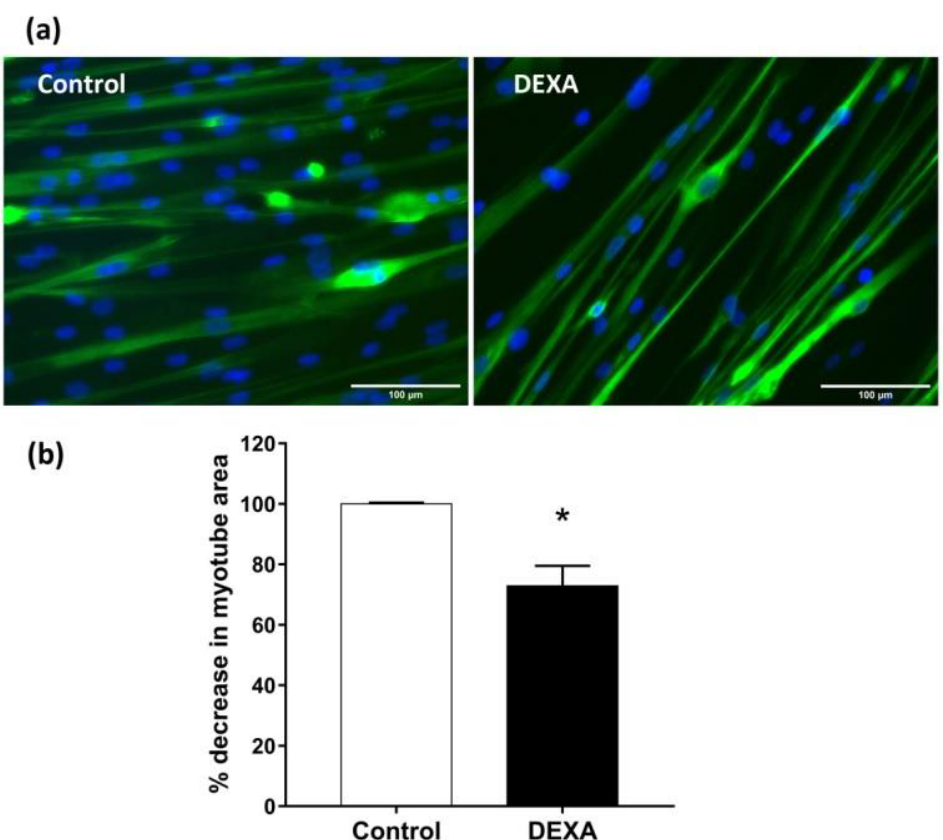
Figure 5. Induction of atrophy in HSMM myotubes. ( a ) Differentiated myotubes were treated with 50 µM of DEXA for 48 h. Representative images of MYH2/Hoechst-labeled myotube (green/blu). ( b ) Plots of the percent decrease, from untreated cells, in myotube area, are shown. Plots represent means ± SEM, n = 10. * p < 0.05 vs. untreated cells (control) using Student’s t -test. (Images at ×20 magnification; scale bar = 100 microns).